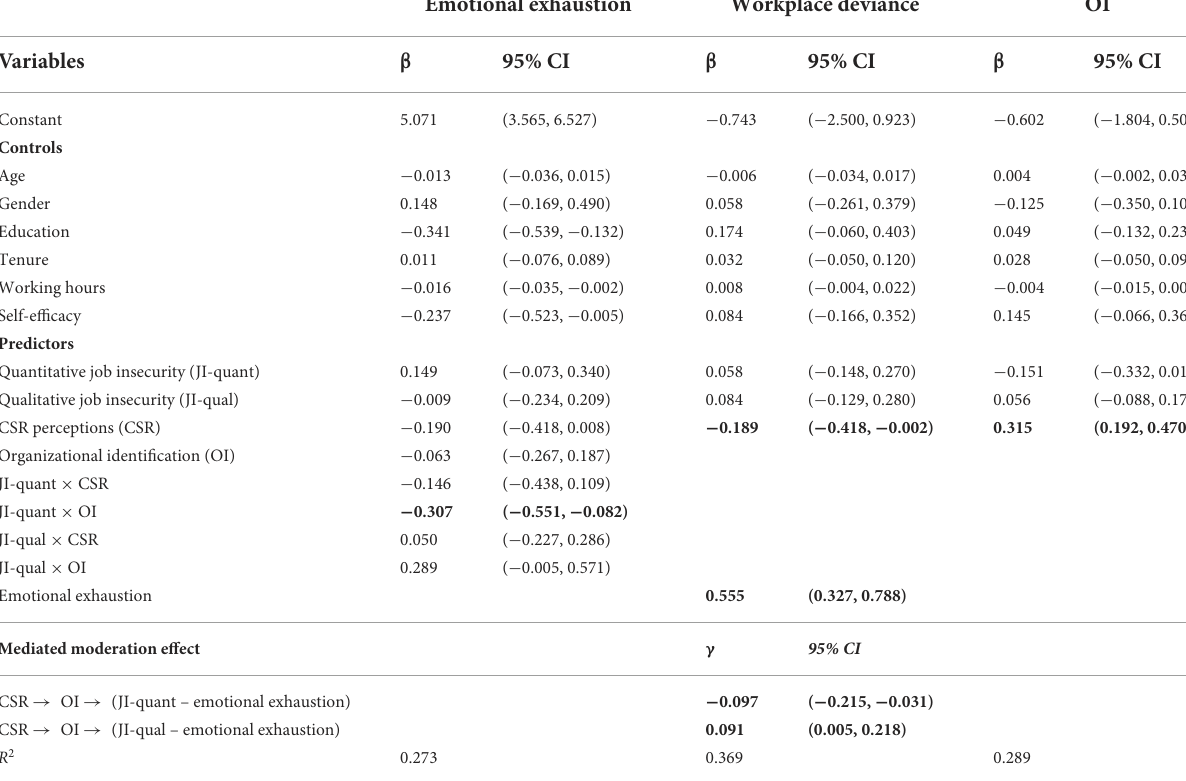
TABLE 6 Supplement analysis 2: results of emotional exhaustion at Time